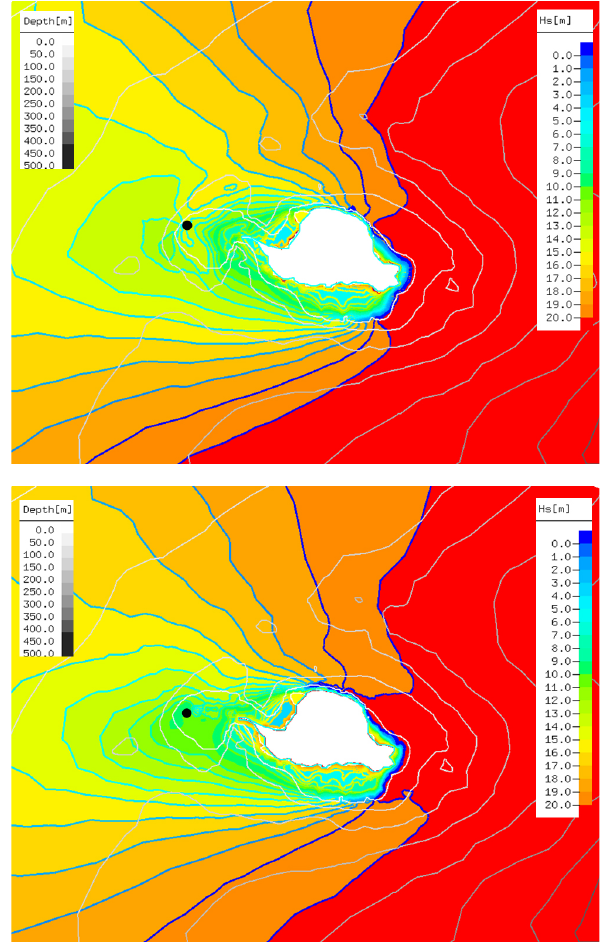
Fig. 9. Refraction characteristics in terms of significant wave height around Guishandao Island based on steady easterly wind of 30ms − 1 (top: SWAN, bottom: WWMII; ∗ black dot indicates the position of the wave buoy). Grey scale for the contours indicate the water-depth isolines. Colour scale on the right describes the significant wave